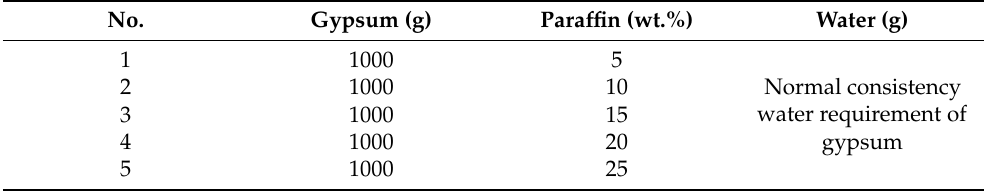
Table 1. Specific compositions of the PA/gypsum composites.